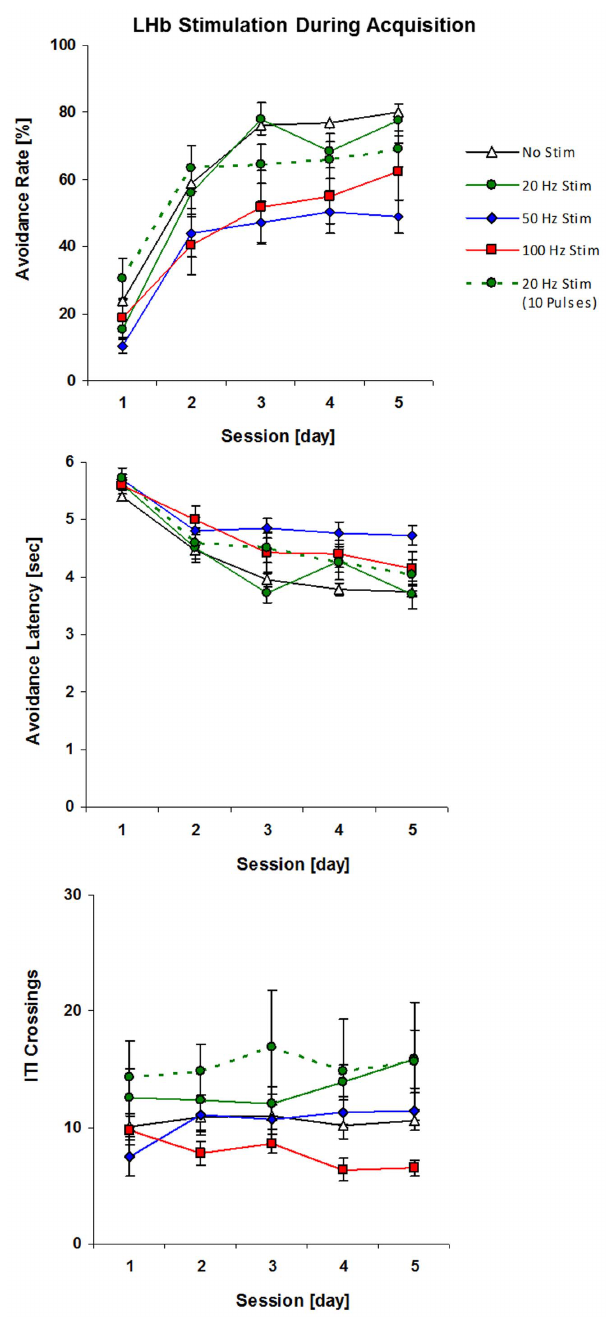
Figure 2. Effect of LHb stimulation on acquisition. Sample size was 22 for the no stimulation group (data from first five sessions were pooled from all the groups which received stimulation during last five sessions), 6 for 20 Hz group, 8 for 50 Hz group and 8 for 100 Hz group. These groups (indicated by solid lines) were stimulated for 200 ms immediately following each successful response. In addition, we included a separate control group (indicated by dashed line, n=8) which was stimulated at 20 Hz for 500 ms, i.e., the same frequency as the 20 Hz group but the same number of pulses as the 50 Hz group. Only the 50 and 100 Hz groups showed learning curves that were significantly different from the no-stimulation group after post hoc correction ( p ,